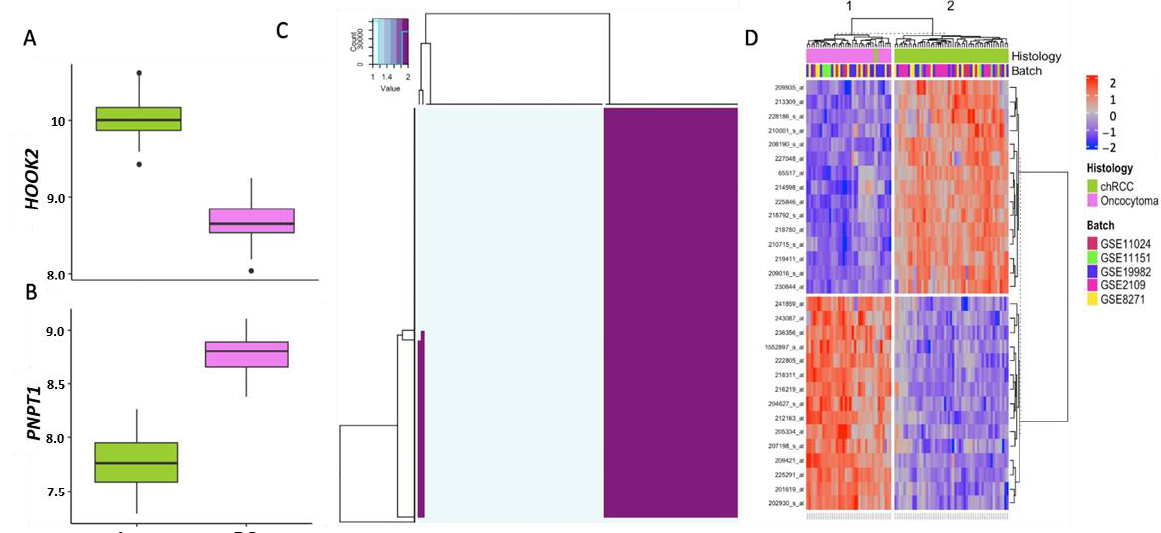
Figure 4. Gene selection and unsupervised model consistency: ( A , B ) boxplot showing log2-transformed expression values for (y-axis) for two representative genes ( HOOK2 and PNPT1 ) from COGS in chRCC (green) and RO (magenta), outliers are represented with points (black); ( C ) group consensus heatmap by DBU with 20 random genes from GS30, showing a consistent classification with unsupervised models; ( D ) heatmap of COGS in meta-analysis showing expression differences between the subtypes.